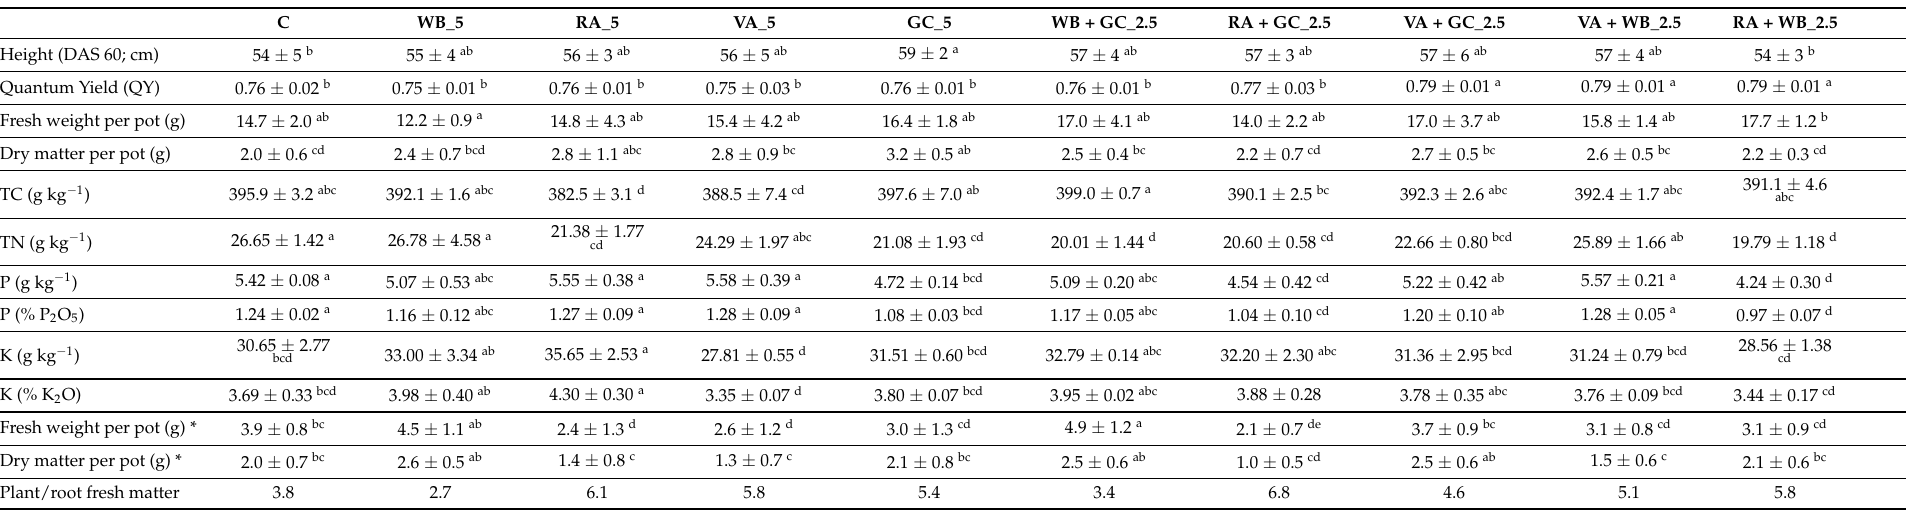
Table 4. Growth parameters and elemental composition (C, N, P and K) of barley plants for each